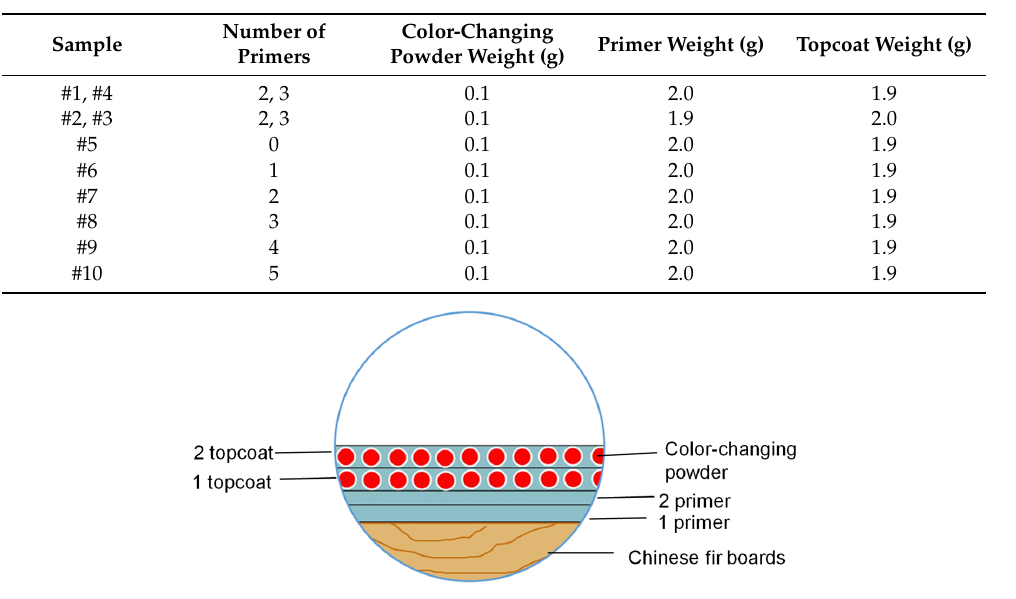
Figure 2. The coating technology of Sample #1.